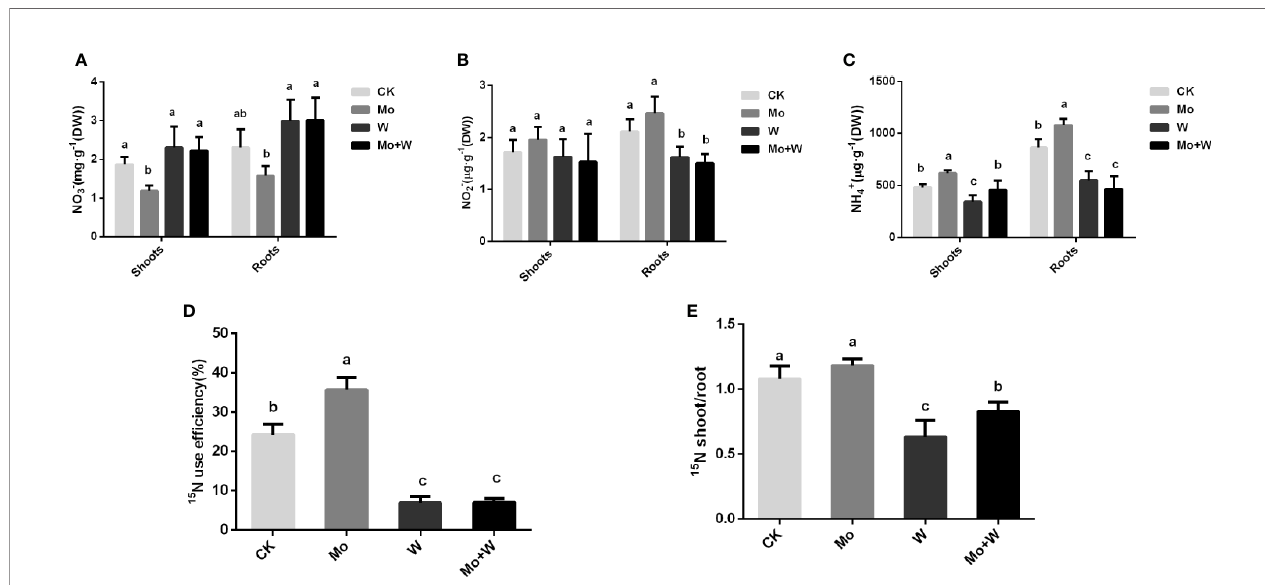
FIGURE 12 | The NO 3- (A) , NO 2- (B) , NH 4+ (C) , 15N use ef fi ciency (%) (D) and 15N shoot/root ratio (E) in strawberry seedlings applied with treatments (CK, Mo, W, Mo+W). Data is presented as the means ± SD, n = 3. Different letters above bars denote statistical signi fi cance according to one-way ANOVA and Duncan ’ s test (P <